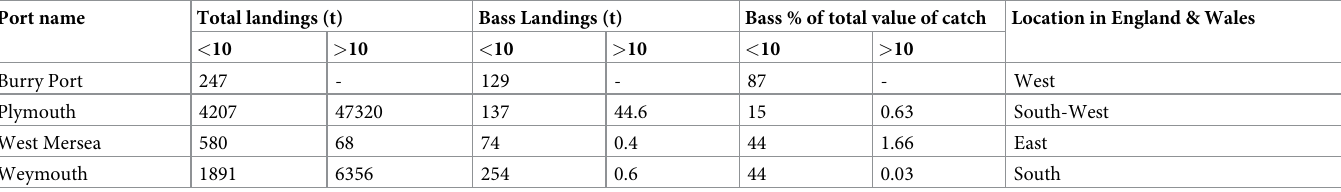
Table 1. Descriptive statistics of the chosen ports from MMO landings data 2014–2018 ( < 10 or > 10 indicated under & over 10-meter fleet